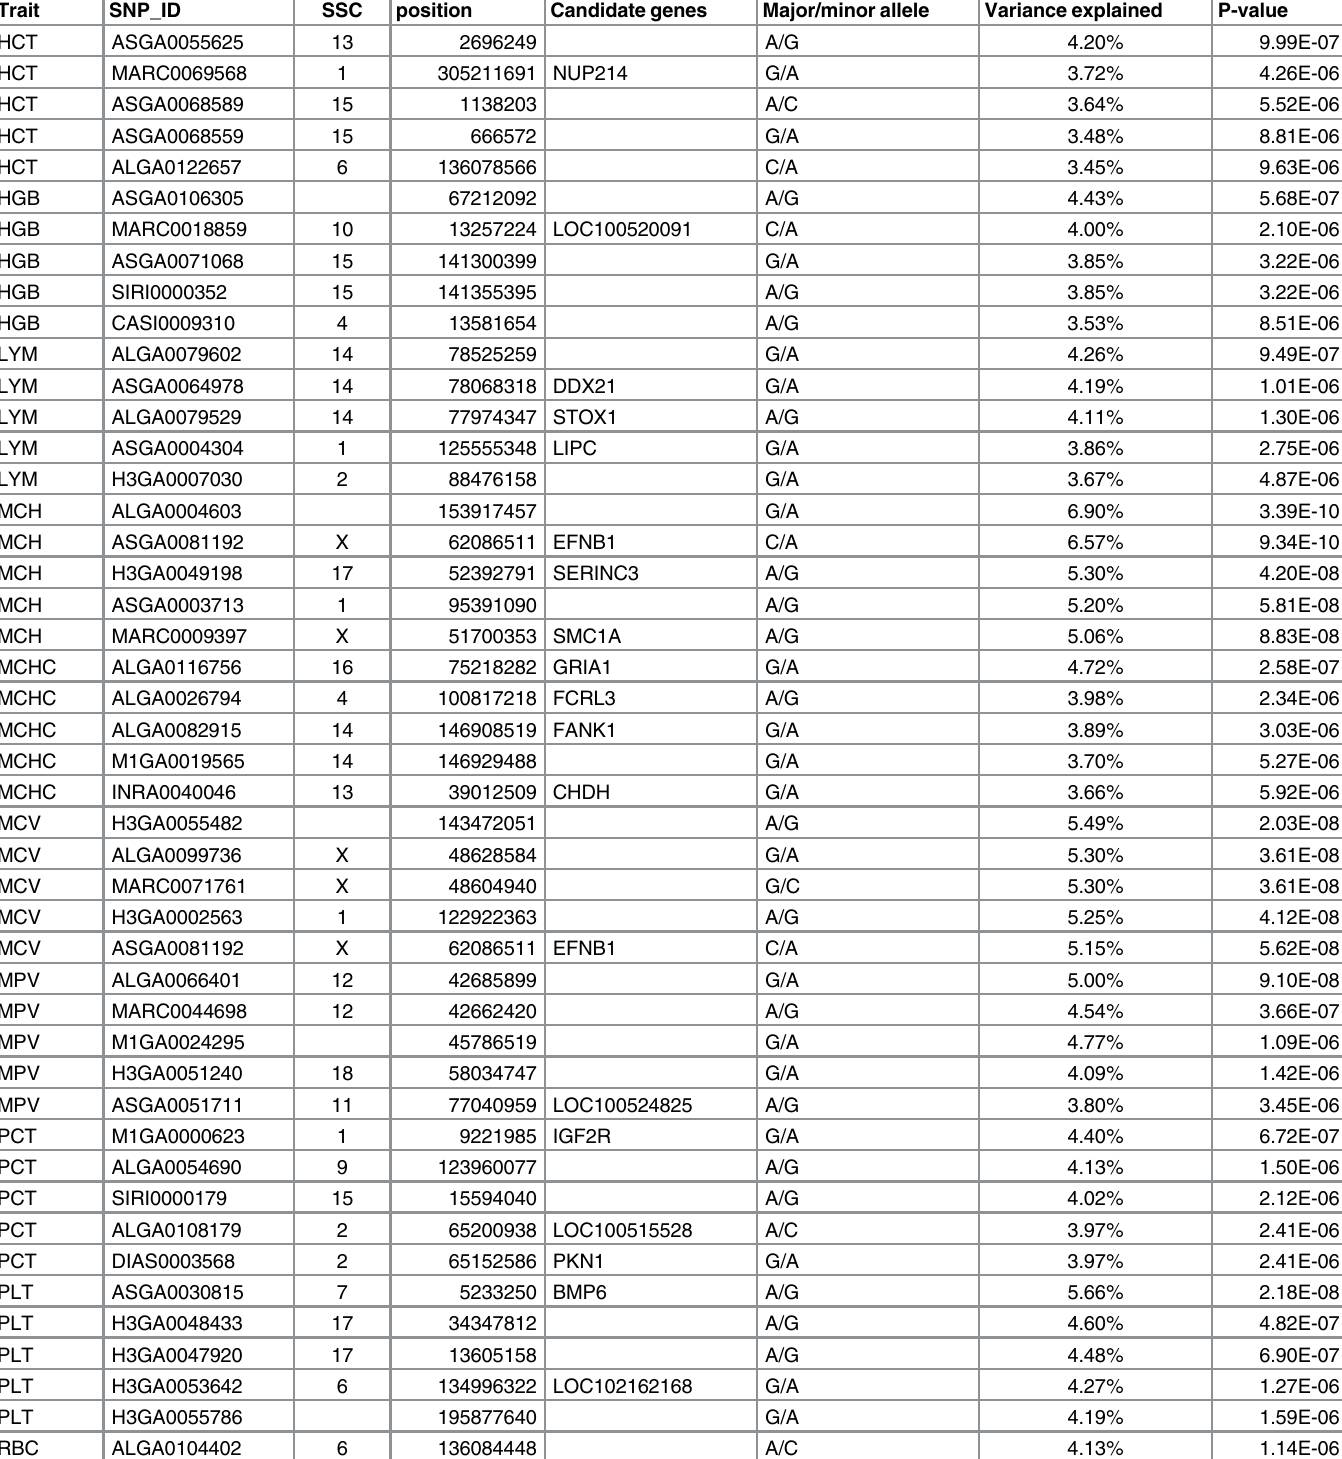
Table 2. Results of single-marker (generalized linear mixed model) genome-wide association analyses in a commercial German Landrace pig population.